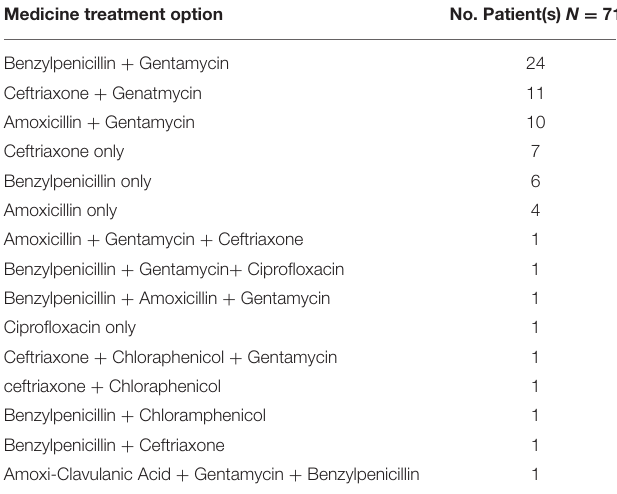
TABLE 2 | Antibiotic treatment for